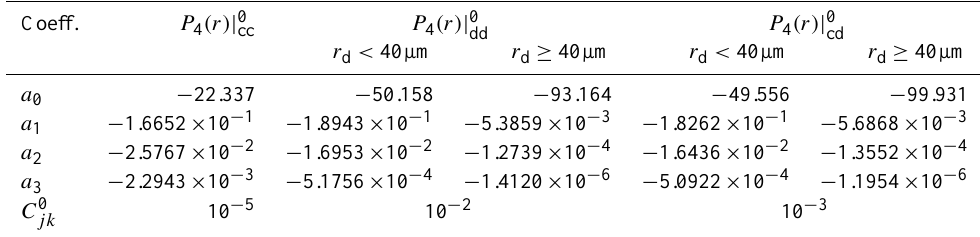
Table A1. The coefficients and scaling used in the four parameter polynomials (cf. Eq. A6) for approximating the zeroth moment, i.e., n = 0, of the integrals in Eqs. (A3)–(A5).